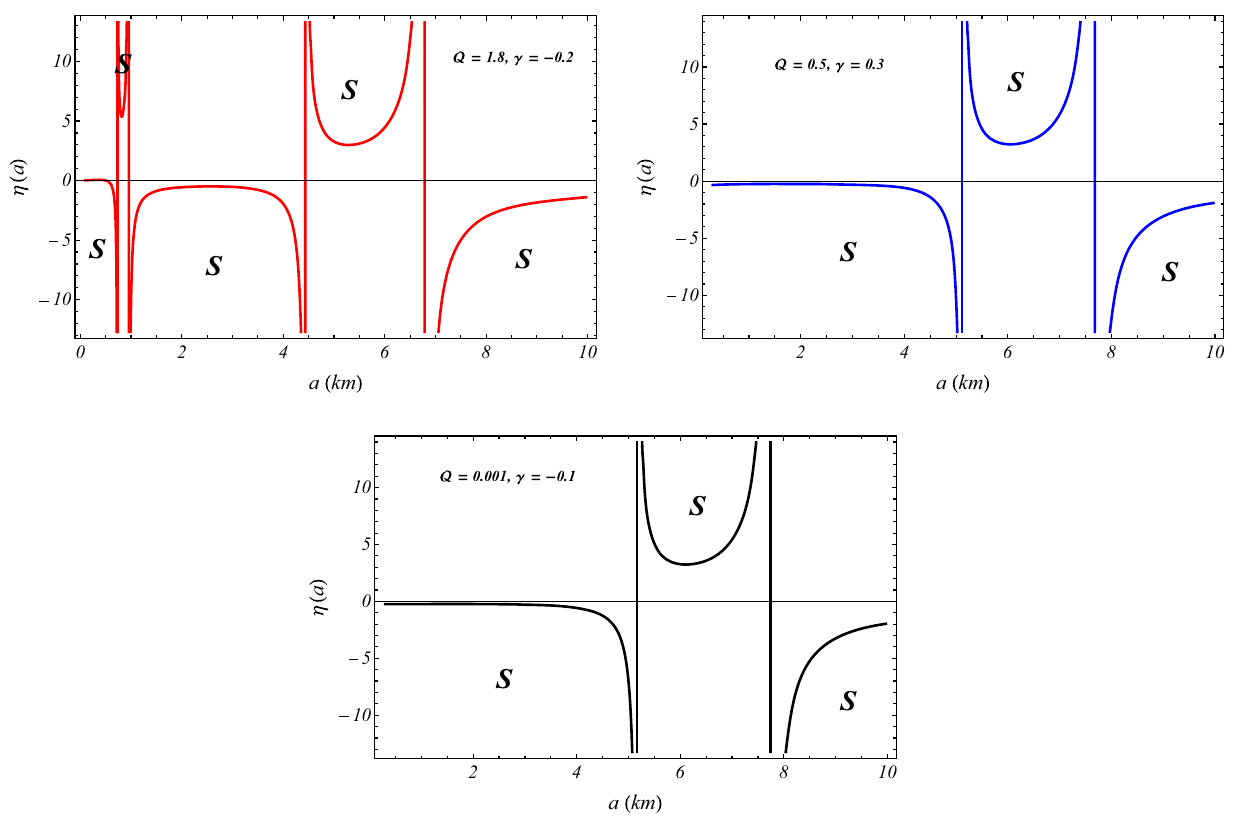
Fig. 10 Stability regions of the charged gravastar. Here ‘ S ’ stands for